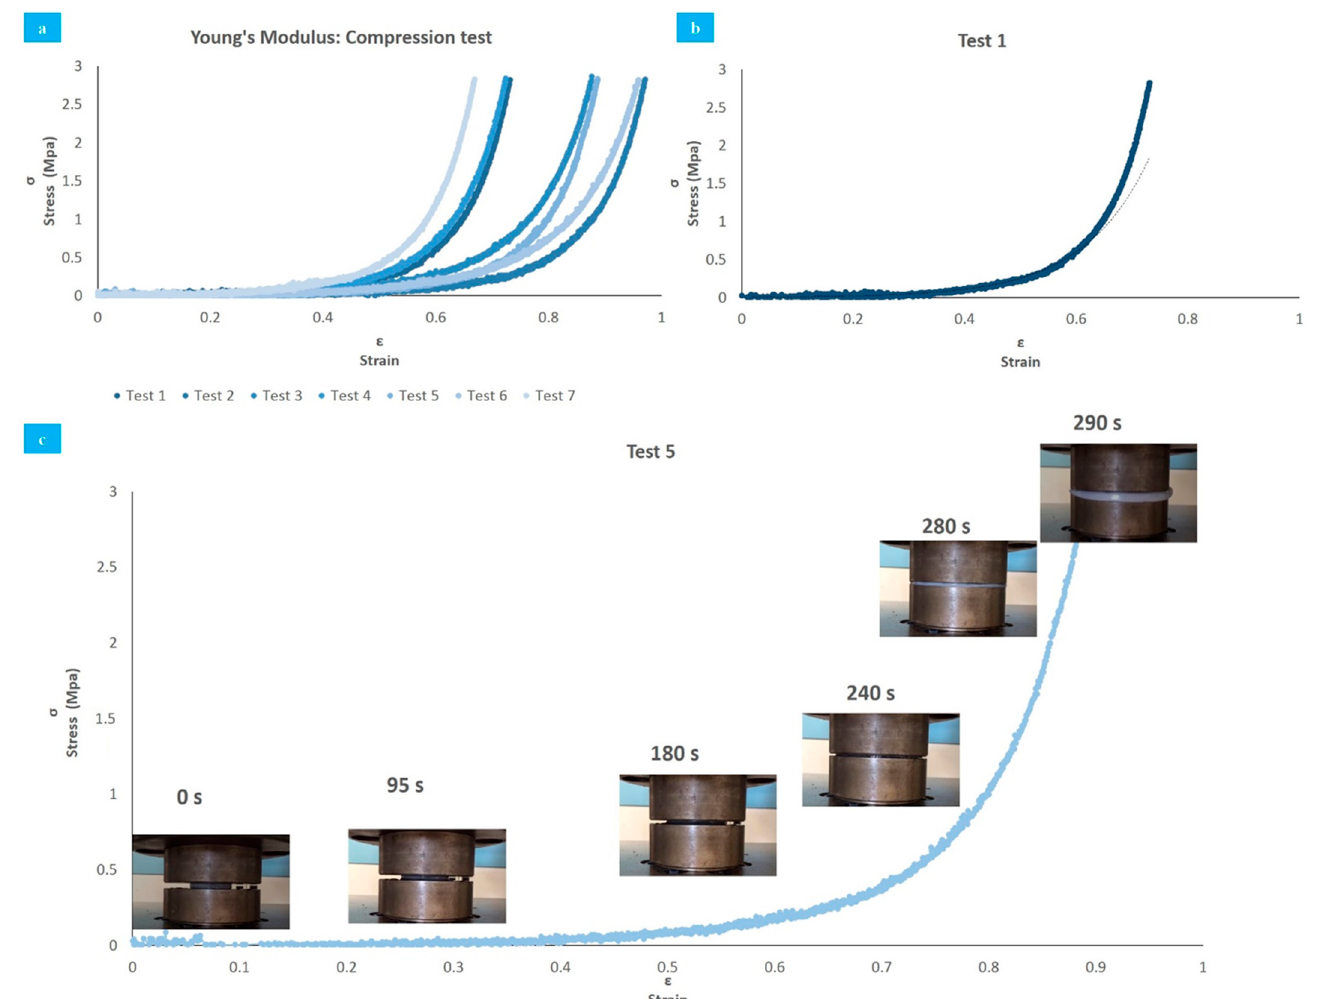
Figure 4. Compression tests (Up to 4500 N, compression rate 1 mm/min). ( a ) Linear regression of all tests; ( b ) exponential behavior of compression modulus in test 1; ( c ) test 5 deformation over time.